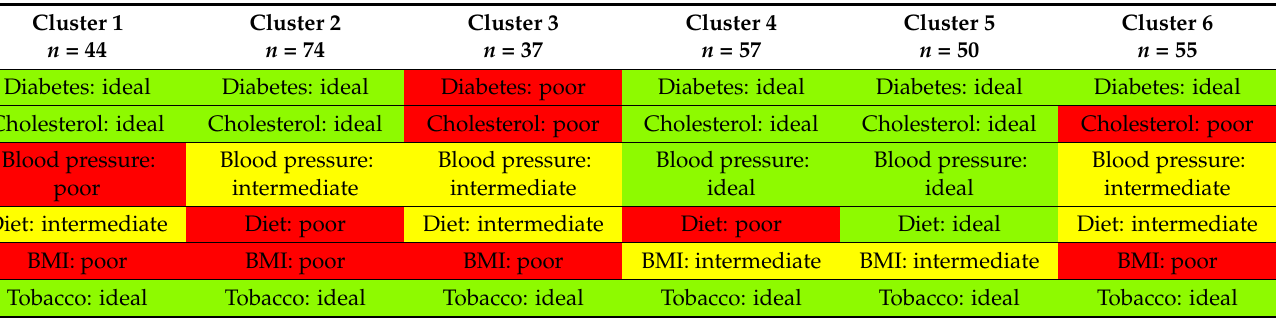
Table 2. Outcome of Two-Step Cluster